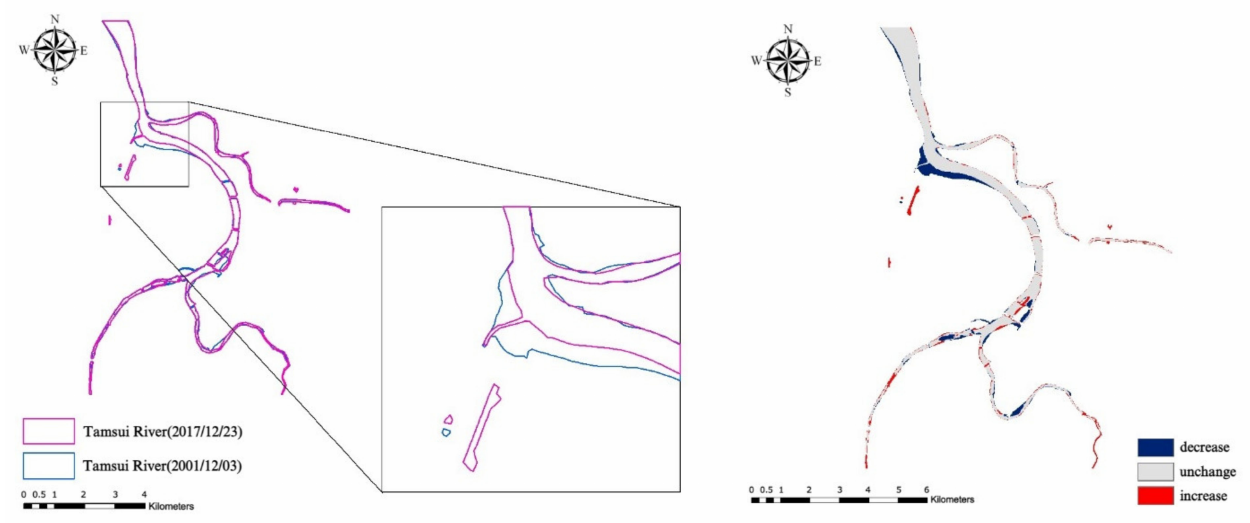
Figure 9. The Tamsui River watershed changes between two epochs.